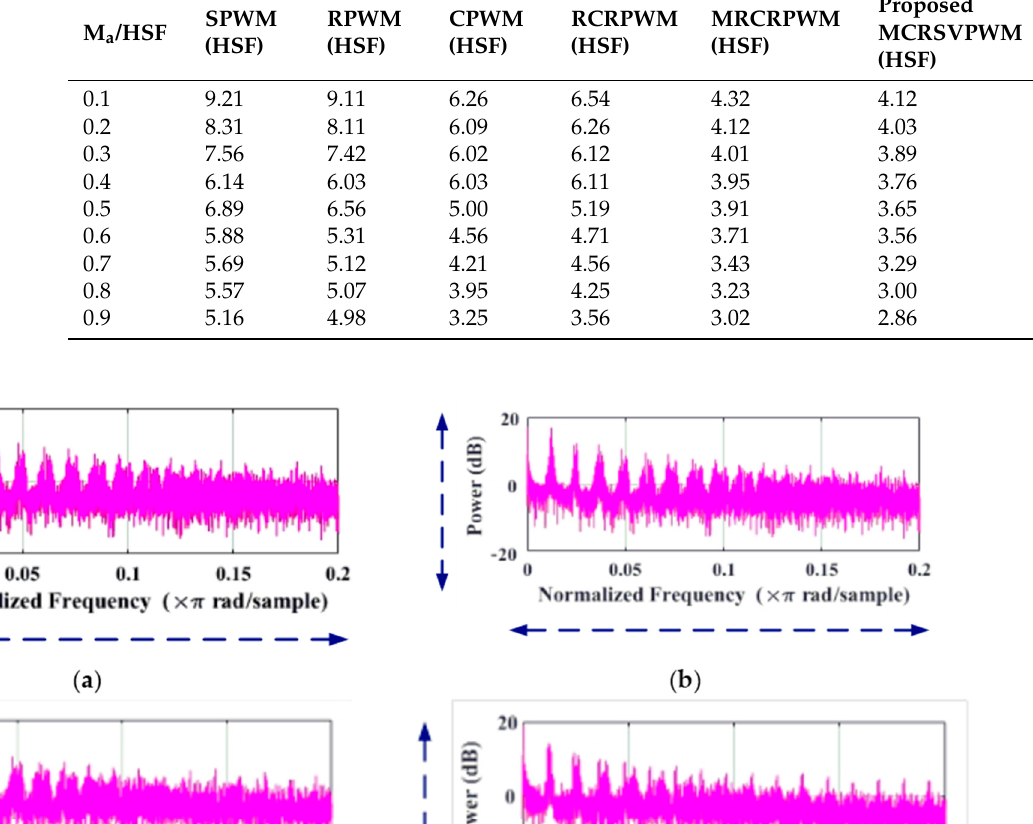
Table 3. Simulation study and HSF results comparisons.